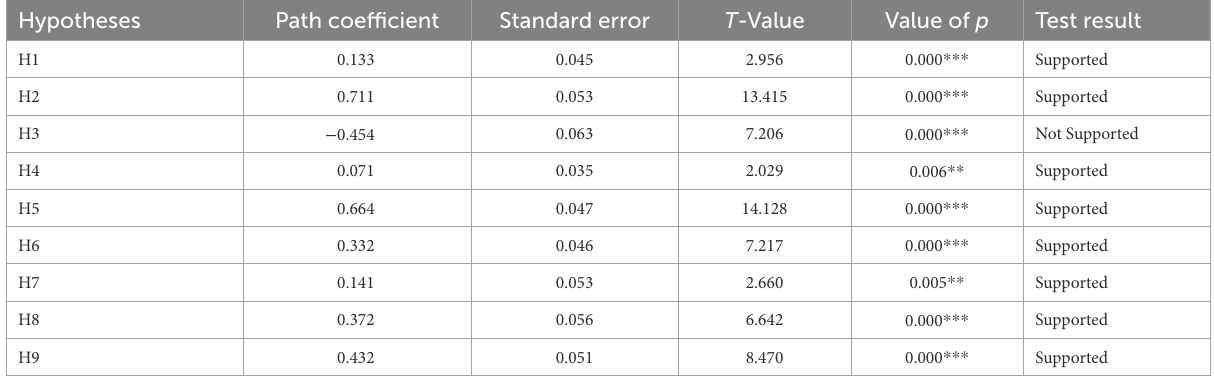
TABLE 10 Summary of hypothesis